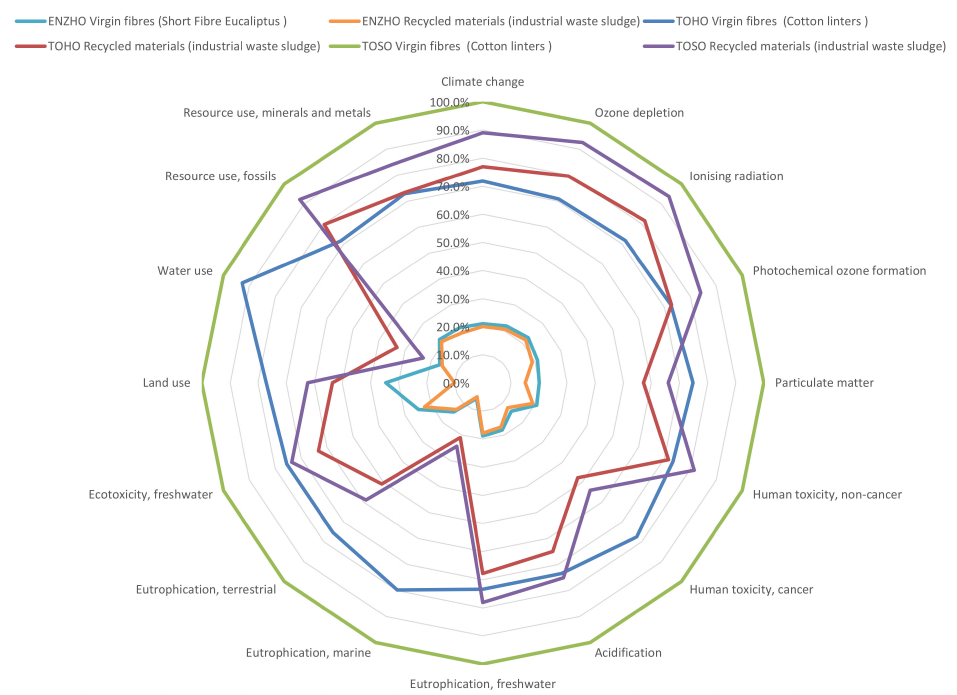
Figure 4. Relative environmental performances of the six CNFs based on the results of the characterisation step. The highest impact per each category is given 100% of the